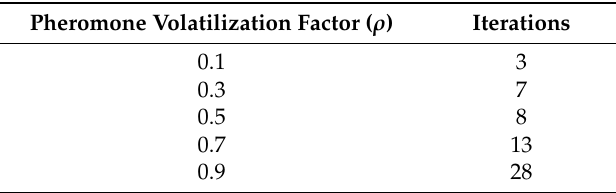
Table 3. The number of iterations with different ρ .